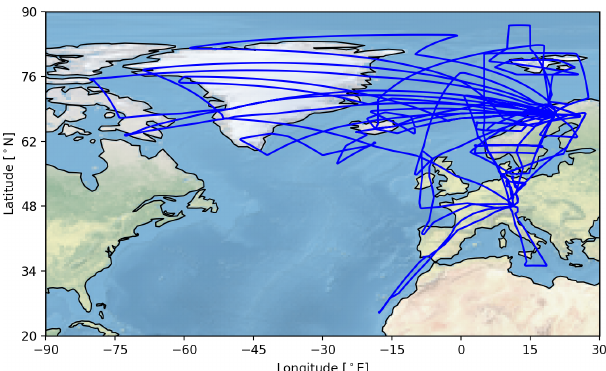
Figure 2. Flight tracks of HALO during the PGS campaign (De- cember 2015 to April 2016). The basis of the campaign was mainly Kiruna in northern